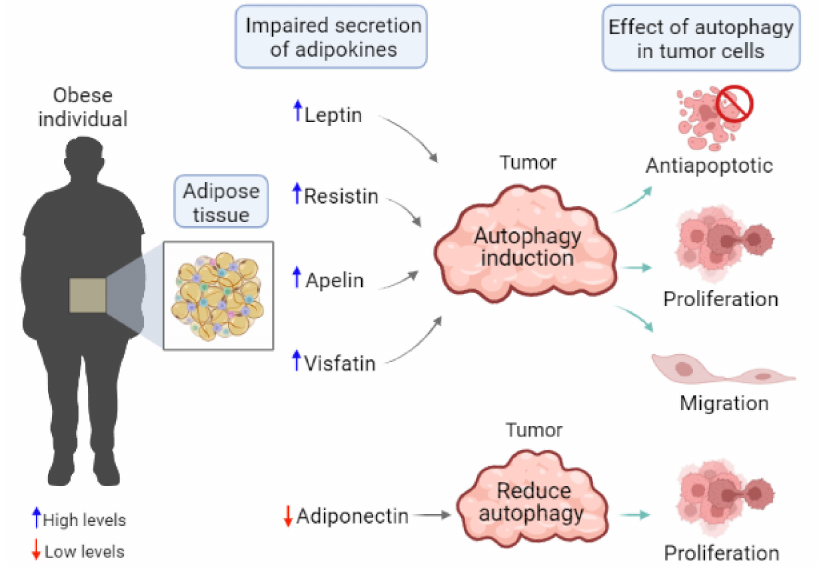
Figure 3. Adipokine-mediated autophagy on tumor cell characteristics during obesity. Adipokines such as leptin, resistin, apelin, and visfatin are elevated in obese individuals with cancer and have been related to a poor prognosis. It has been demonstrated that these adipokines induced autophagy in tumor cells. Adipokine-induced autophagy has been associated with pro-tumoral effects, such as the evasion of apoptosis, increased proliferation, and cell migration. On the other hand, adiponectin is the only adipokine present at low levels in an obese individual. The effect of low adiponectin conditions on autophagy is still being explored. However, in a breast cancer transgenic mouse model, it was demonstrated that whole-body adiponectin deficiency increased tumor growth. Tumor progression was attributed to a lack of autophagy induction and decreased autophagic degradation of LDL receptor in the absence of adiponectin. These results suggest an essential role for adiponectin deficiency in regulating lipid metabolism in obesity-associated malignancies through the regulation of